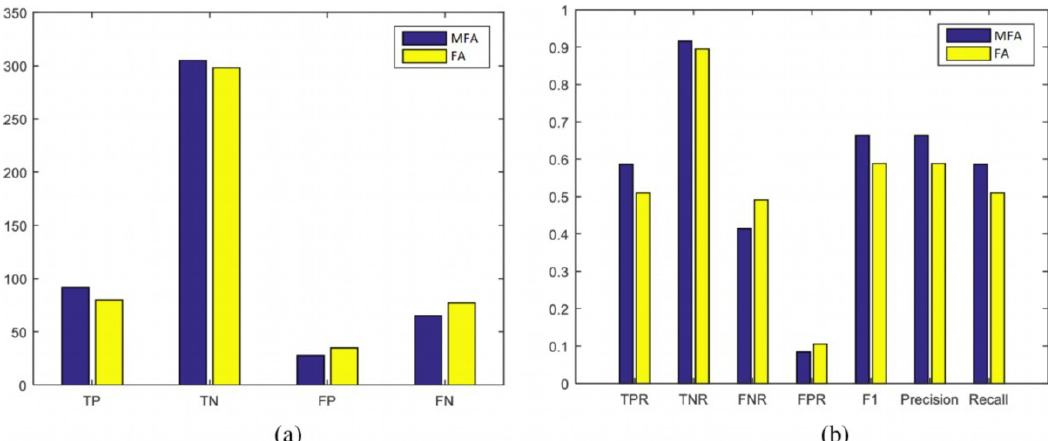
Figure 16. Scenario 1: Statistical evaluation of MFA-OSELM and FA-OSELM using two sets of measures, ( a , b ), for the TampereU dataset.